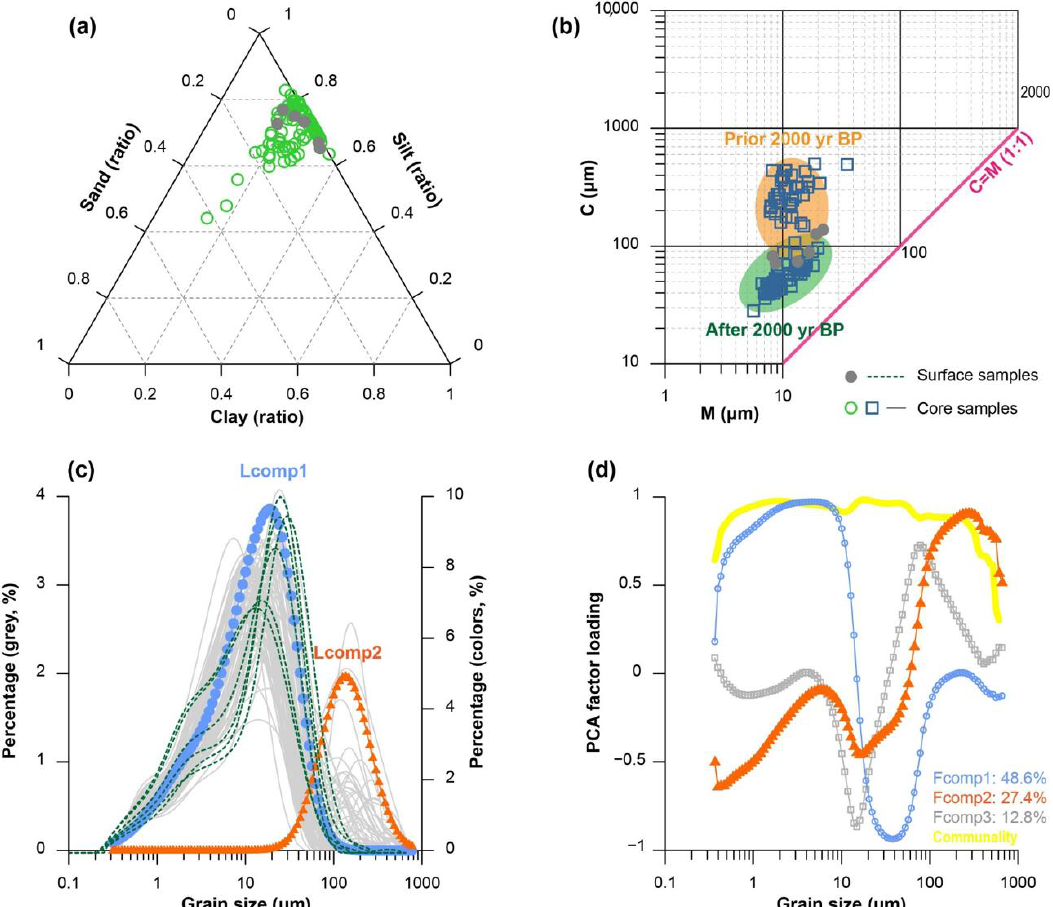
Figure 3. Characteristics of sediment grain size of core ECS-DZ1 and six surface samples. ( a ) Ternary diagrams; ( b ) C-M diagrams; ( c ) grain size distribution; ( d ) principal component analysis.